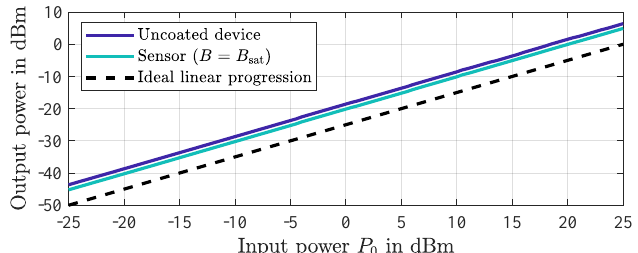
Figure 8. Measured output power as a function of input power P 0 of the two investigated SAW delay lines, i.e., the magnetostrictively uncoated device and the sensor in magnetic saturation. A strict linearity is revealed for both devices. The measurements were performed with a calibrated setup consisting of a signal generator SMBV100A and a signal and spectrum analyzer FSV , both from Rohde & Schwarz